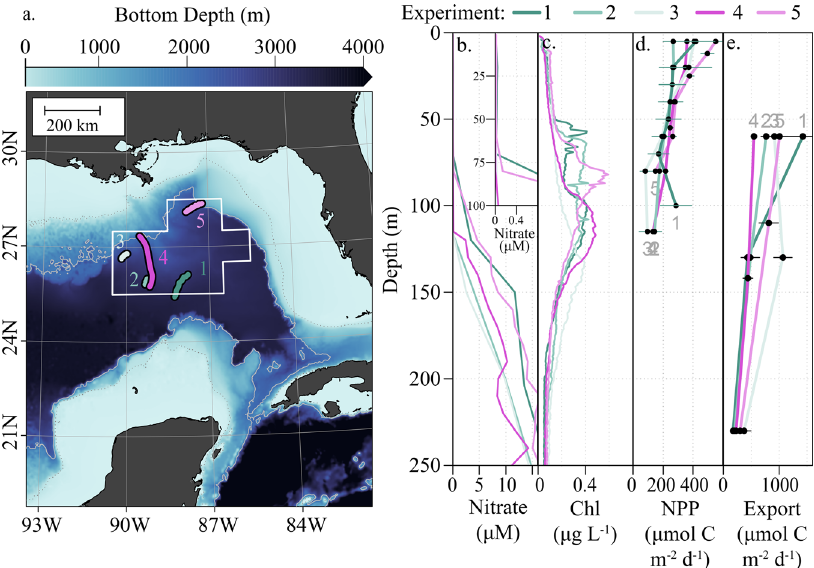
Fig. 1 Overview of in situ data. a Study locations in the central Gulf of Mexico (GOM; colored drift trajectories) with a white outline indicating the integration volume from surface to 55 m considered as representative of the eastern Central GoM (depths >2000 m, outside the general fl ow of the loop current). b Vertical pro fi les of nitrate concentrations with inset detailing low surface concentrations. c Vertical pro fi les of chlorophyll concentrations as recorded by calibrated fl uorometer. d Vertical pro fi les of net primary productivity and e vertical pro fi les of particulate nitrogen export at three depths: upper euphotic zone, lower euphotic zone, and 200 m. Colors correspond to Lagrangian experiments, and error bars indicate ± 1 SD of means for measurements during